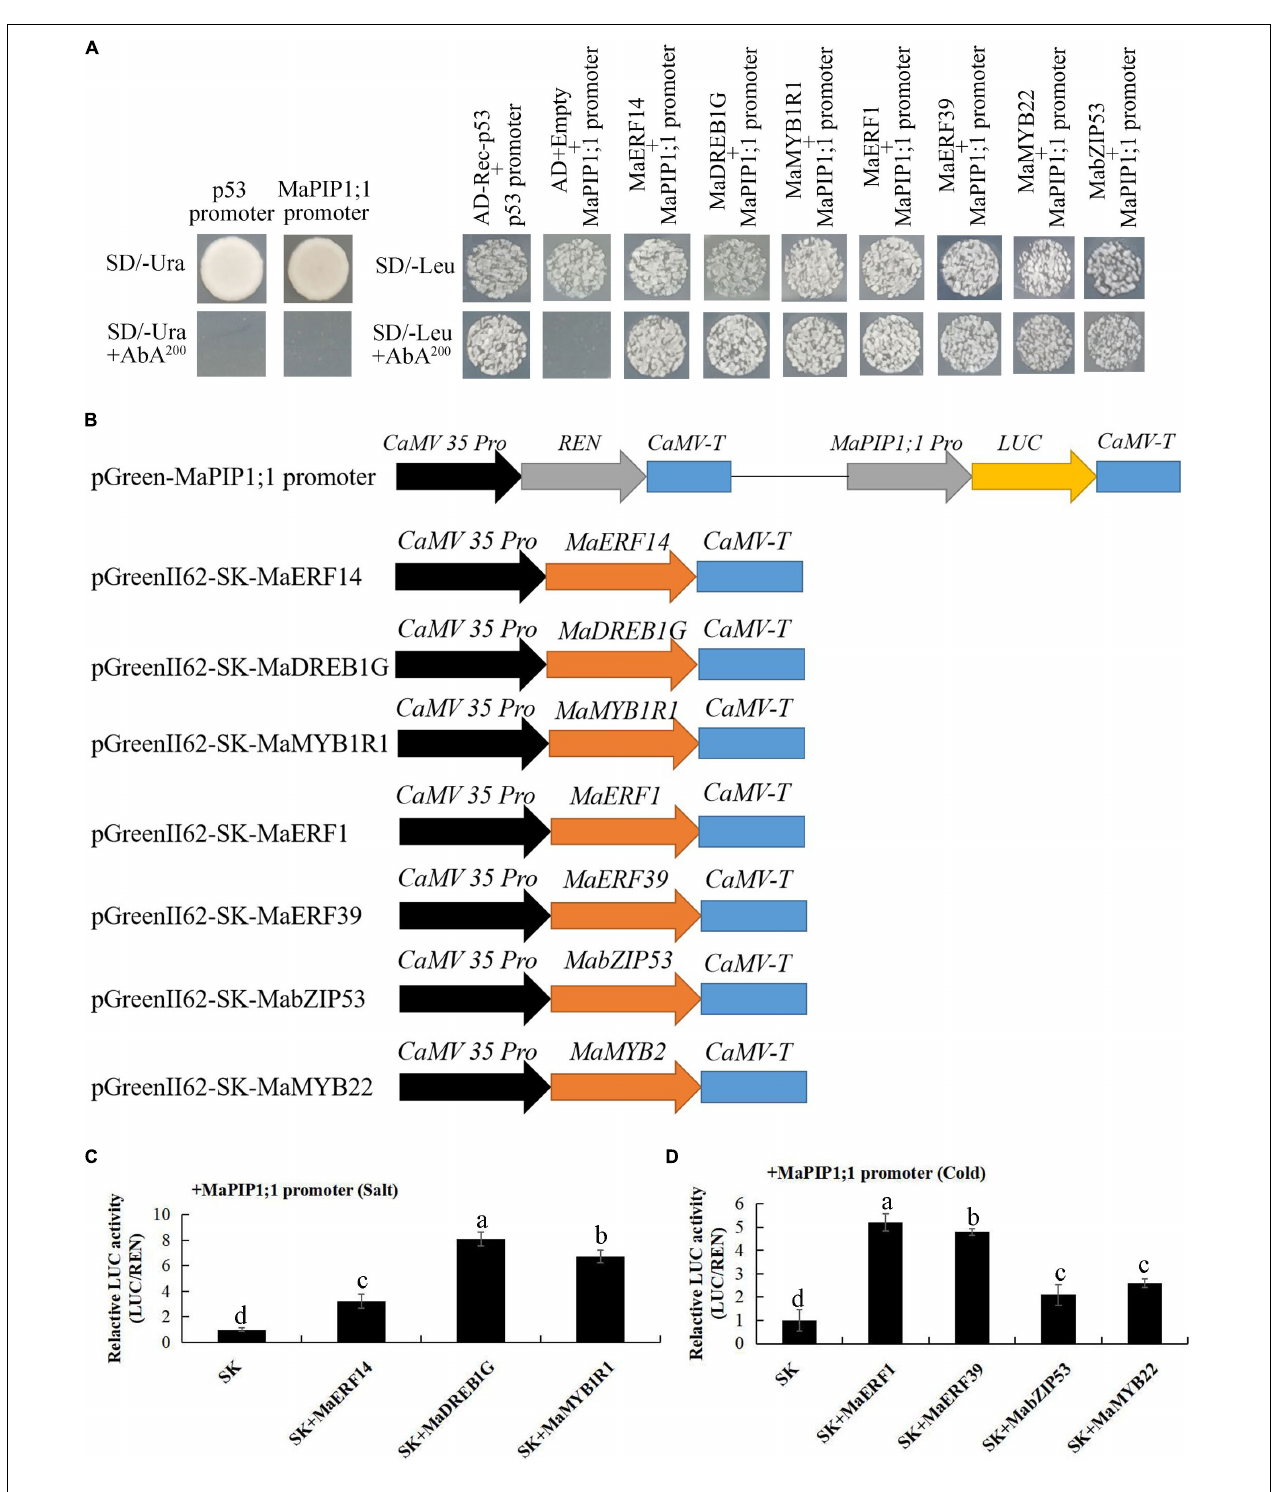
FIGURE 10 | Activation of the MaPIP1;1 promoter by the transcription factors. (A) Physical interactions between MaERF14, MaDREB1G, MaMYB1R1, MaERF1/39, MabZIP53, MaMYB22, and the MaPIP1;1 promoter according to yeast one-hybrid analysis. The autoactivation of the promoters was determined on SD/-Ura + AbA media, while the interaction between TFs and the promoter was tested on SD/-Leu + AbA media. (B) Schematics of transient expression vectors. (C,D) LUC activity resulting from the transient co-expression of the MaPIP1;1 promoter and the transcription factors in Agrobacterium tumefaciens strains. There were three replicates. The data are presented as the means ± SDs. Means denoted by the same letter are not significantly different at P < 0.05 as determined by Duncan’s multiple-range test.